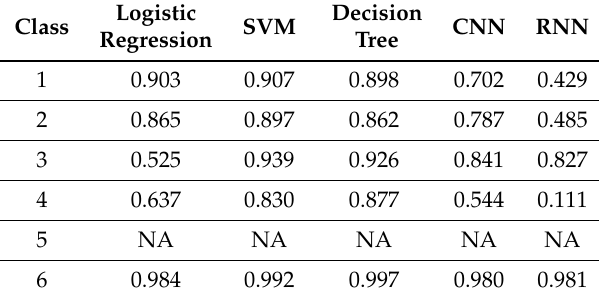
Table 11. Classifier recall